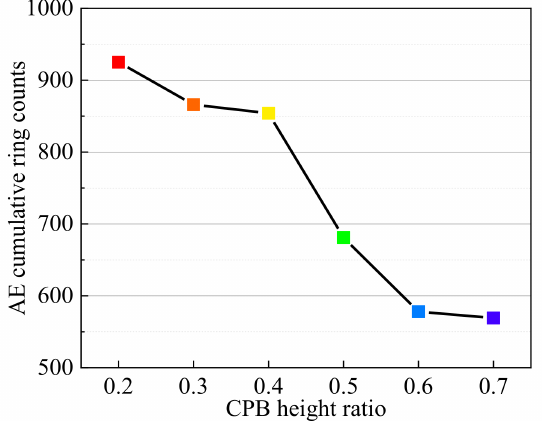
Figure 8. AE cumulative ring count of RCF material at peak